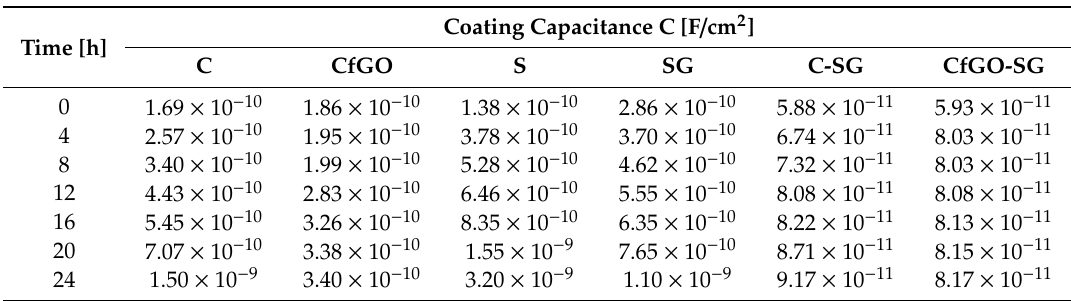
Table 4. Coating capacitance values of the six samples series during the first 24 h of